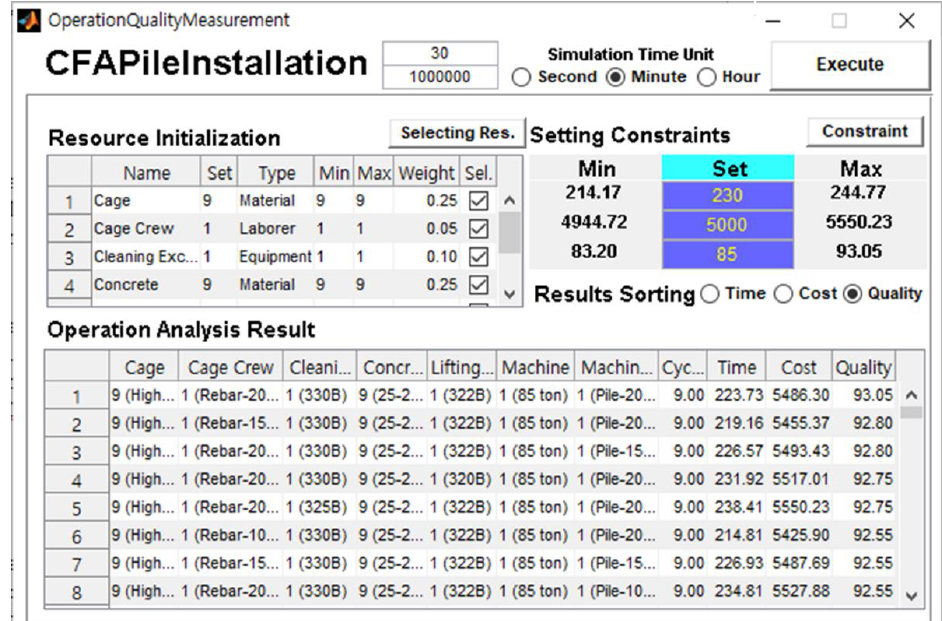
Figure 3. Graphic user interface for choosing available types of resources.